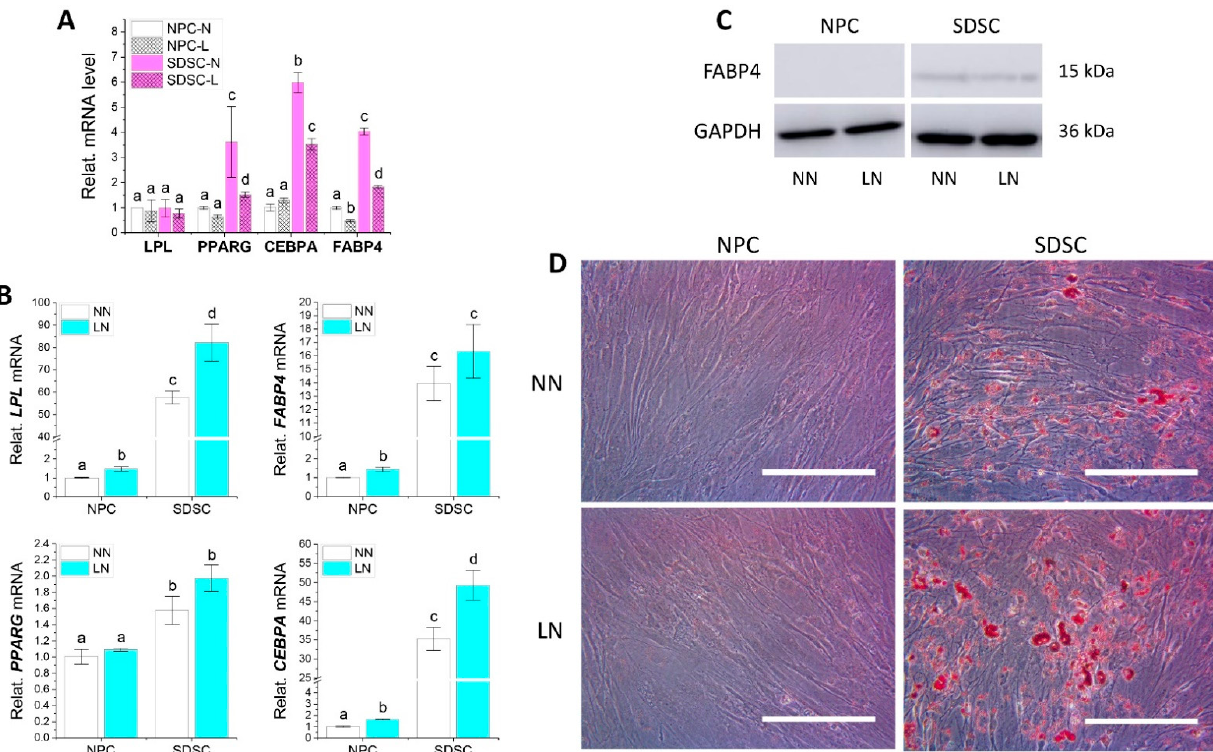
Figure 5. Evaluation of the effect of hypoxia pretreatment on adipogenic potential of fetal MSCs. Fetal NPCs and SDSCs after normoxia (N) or hypoxia treatment (L) were incubated for 21 days in adipogenic induction medium. Adipogenic marker genes LPL , FABP4 , PPARG , and CEBPA were assessed using RT-qPCR before ( A : cell sample) and after induction ( B : day 21 samples), normalized against GAPDH levels as an internal control. Data ( n = 4) are represented in bar charts. Different letters indicate a statistically significant difference compared to the groups within the same gene type ( p < 0.05). Western blot was used to detect FABP4 expression ( C ) in fetal MSCs after adipogenic induction. GAPDH was used as an internal control. Oil Red O (ORO) staining was used to detect lipid droplets ( D ).